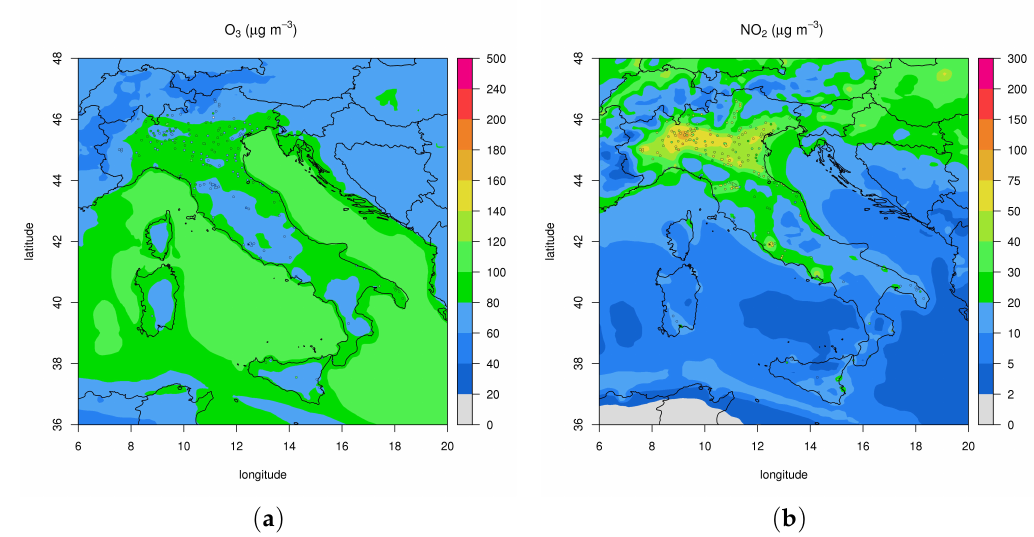
Figure 12. Seasonal average of model (maps) and measurements (filled circles) of O 3 concentration ( µ g m − 3 ) for JJA season ( a ) and NO 2 ( b ) concentration ( µ g m − 3 ) for DJF